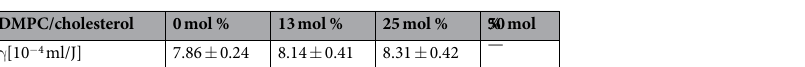
Table 1. Proportionality factor γ between excess heat capacity Δ c p and excess volume expansion coefficient α v . The values for 0 mol%, 13 mol% and 25 mol% cholesterol were determined from the data in Fig.